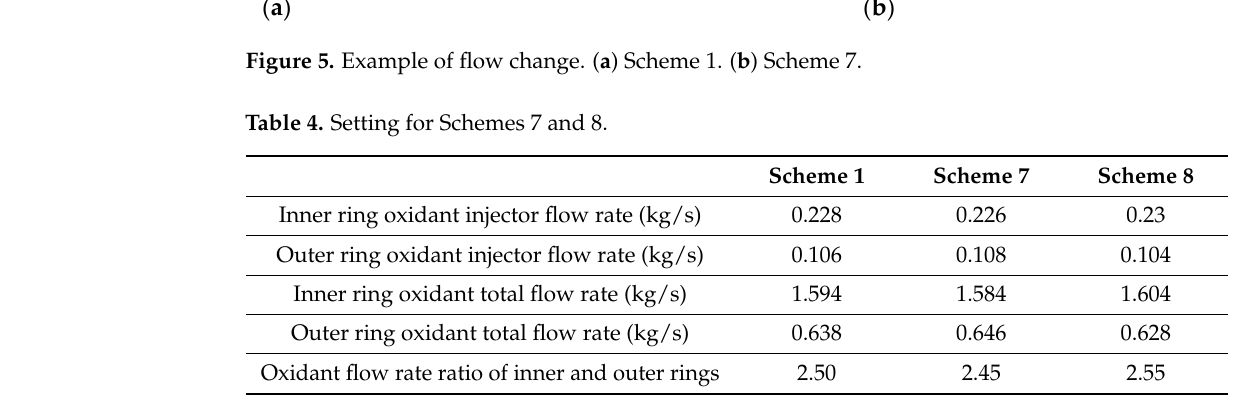
Table 5. Rough estimation of each modal frequency of the combustion chamber.